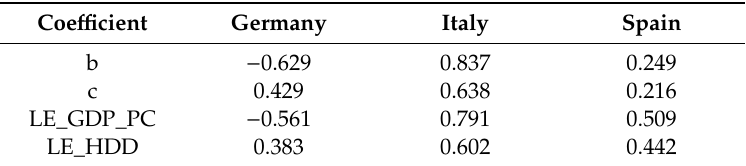
Table 4. Elasticities